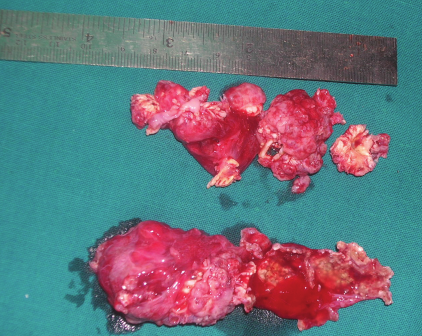
Figure 4: Gross picture showing a lobulated and smooth